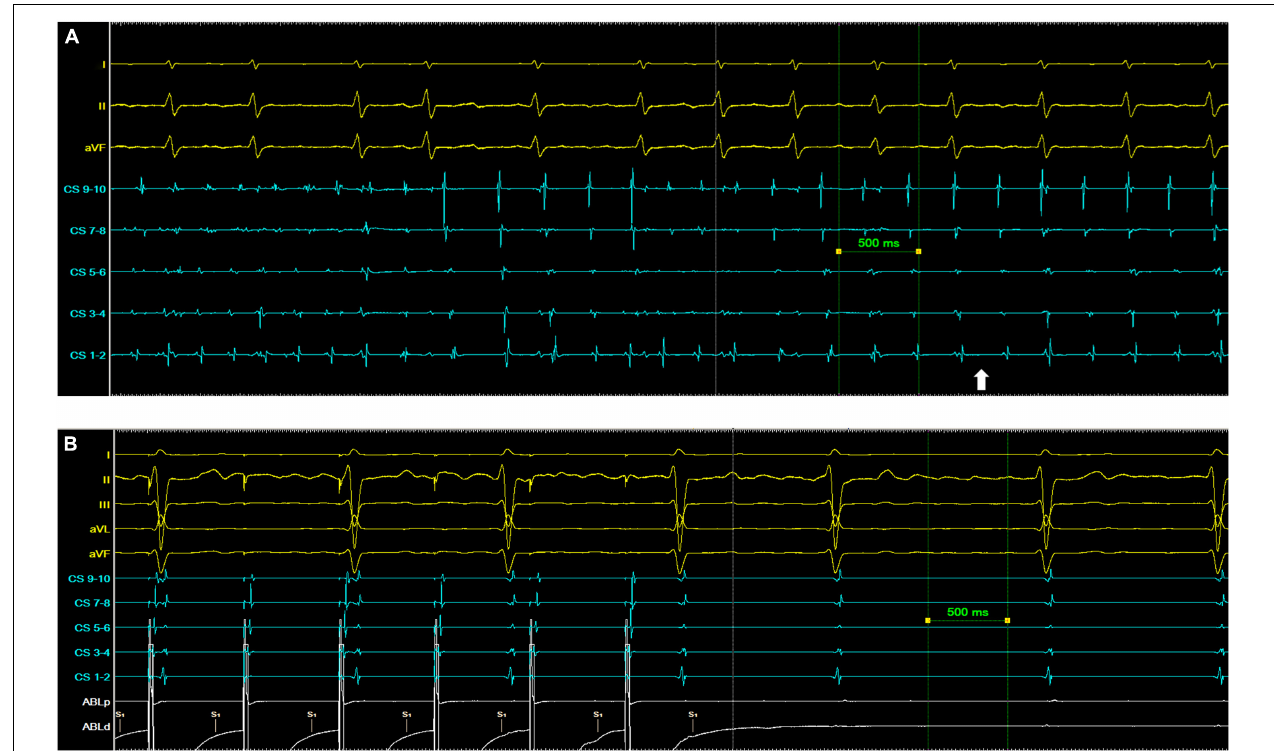
FIGURE 3 | Examples of AF termination following ablation of a region of highest dominant frequency. (A) Patient 5. The white arrow indicates the point of transition from AF to a persistent organized atrial tachyarrhythmia. (B) Patient 7. The left atrium is silent with no coronary sinus (CS) signal at baseline, but with ECG evidence of ongoing AF. Pacing from the ablation (Abl) catheter captures the CS with organized distal to proximal activation.